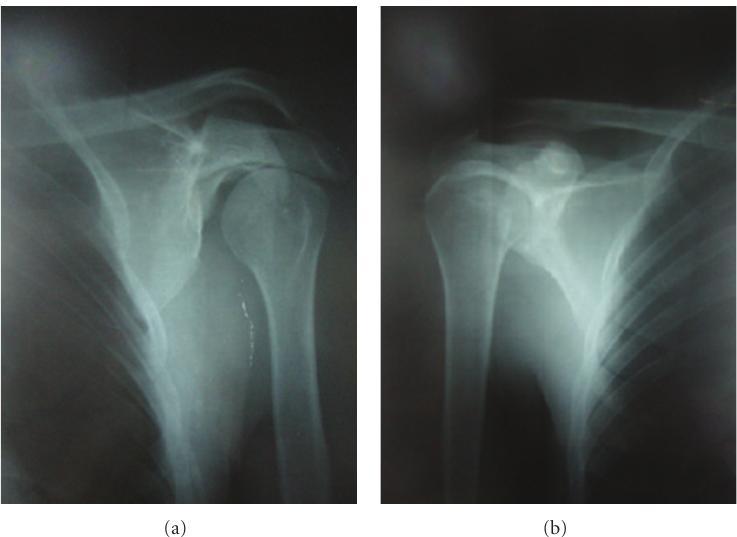
Figure 1: (a) shows Left-sided glenoid hypoplasia with normal humeral head. (b) shows normal right-sided shoulder radiograph.